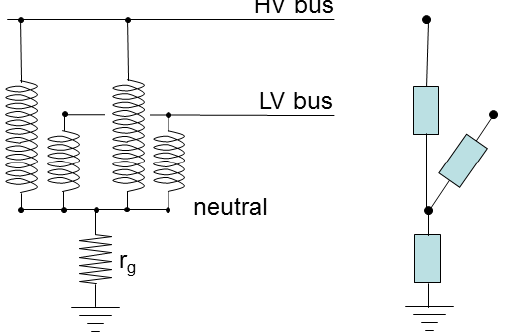
Figure 4. Scenario 1. Substation with two-winding transformers and equivalent admittances for inclusion in the network model.